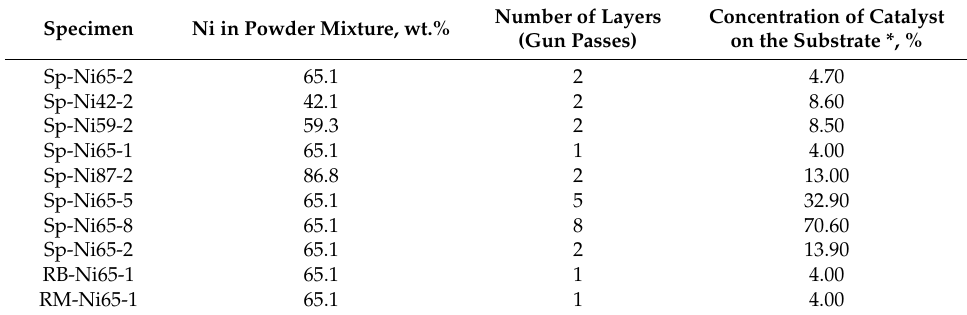
Table 1. Various CAFSY tests and corresponding concentration of catalyst on various substrates. Number of Layers Concentration of Catalyst Specimen Ni in Powder Mixture, wt.% (Gun Passes) on the Substrate *, wt.%